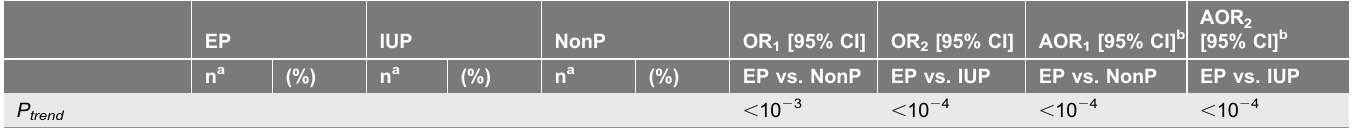
previous infertility, previous adnexal surgery, and previous